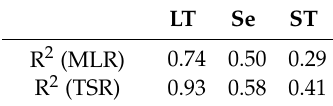
Table 3. Comparison of the coefficient determination (R 2 ) for the MLR and TSR